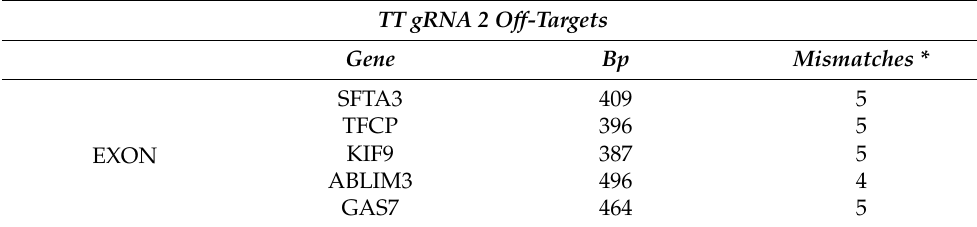
Table 1. Off-target gene